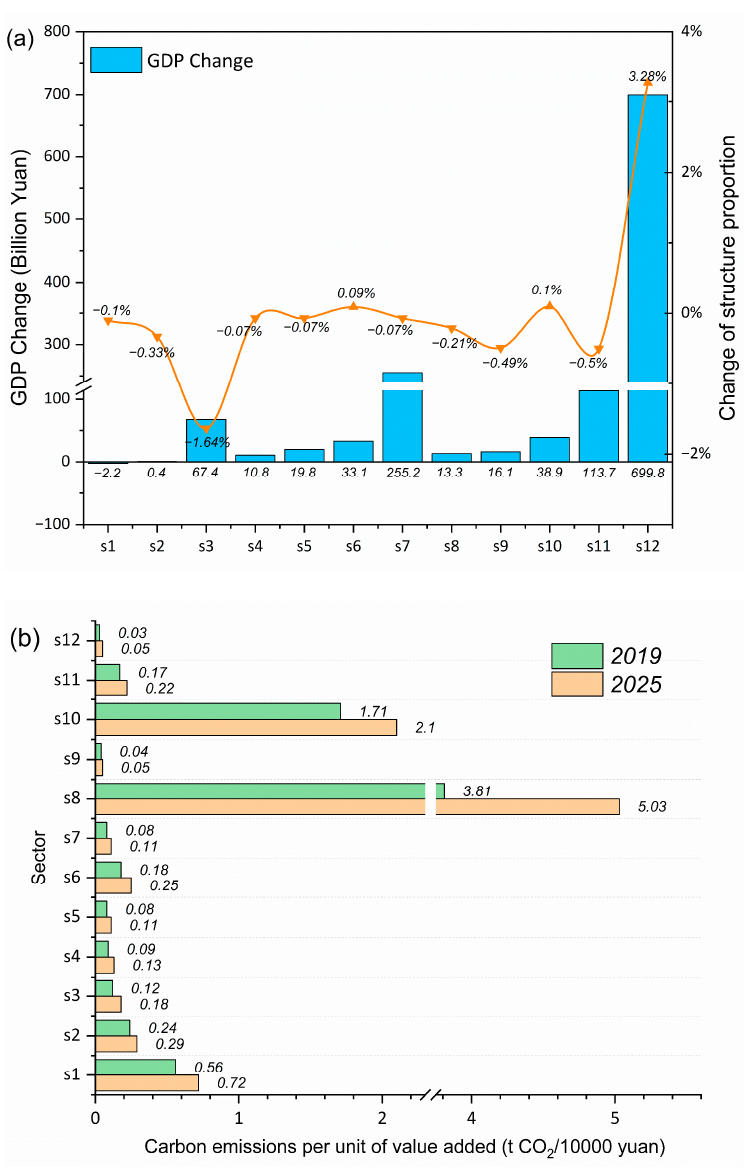
Figure 2. ( a ) Shenzhen’s actual values of activity (GDP) and structure change (sectoral value added in GDP), and ( b ) carbon intensity (carbon emissions per unit of value added) for each sector in 2019 − 2025 (Based on 2019).